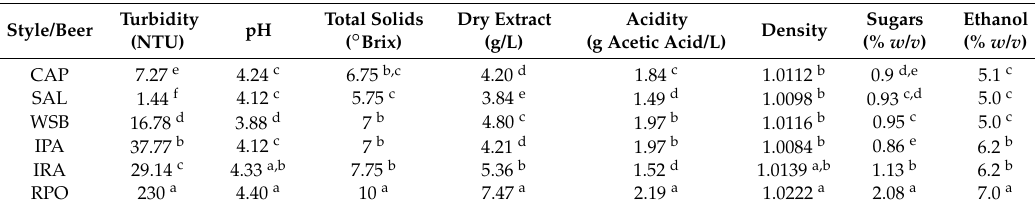
Table 2. Principal quality parameters of each craft beer. Classic American pilsner (CAP), standard porter (RPO). Different letters in the same column indicate significant differences between groups of beers ( p < 0.05, ANOVA followed by